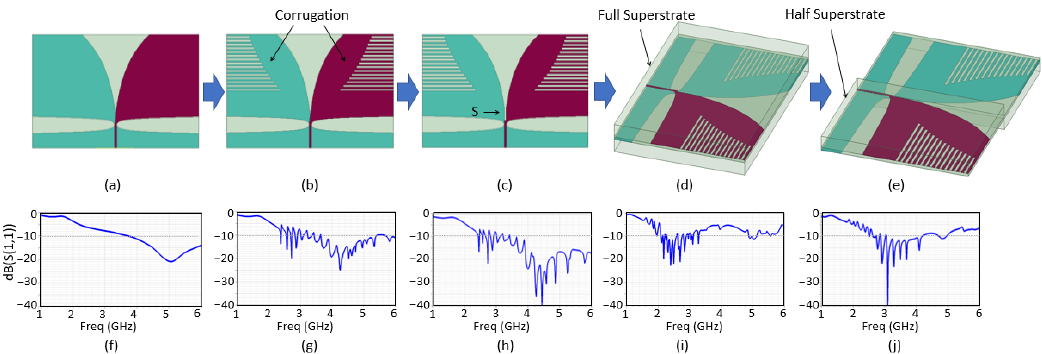
Figure 1. ( a – e ) Design evolution of the proposed antenna 1: ( a ) conventional antipodal Vivaldi design, ( b ) addition of corrugations, ( c ) addition of feed slot (S), ( d ) addition of superstrates, ( e ) reduction of the width of the superstrates, ( f – j ) reflection coefficient (S 11 ) of the antenna after each stage of the design.